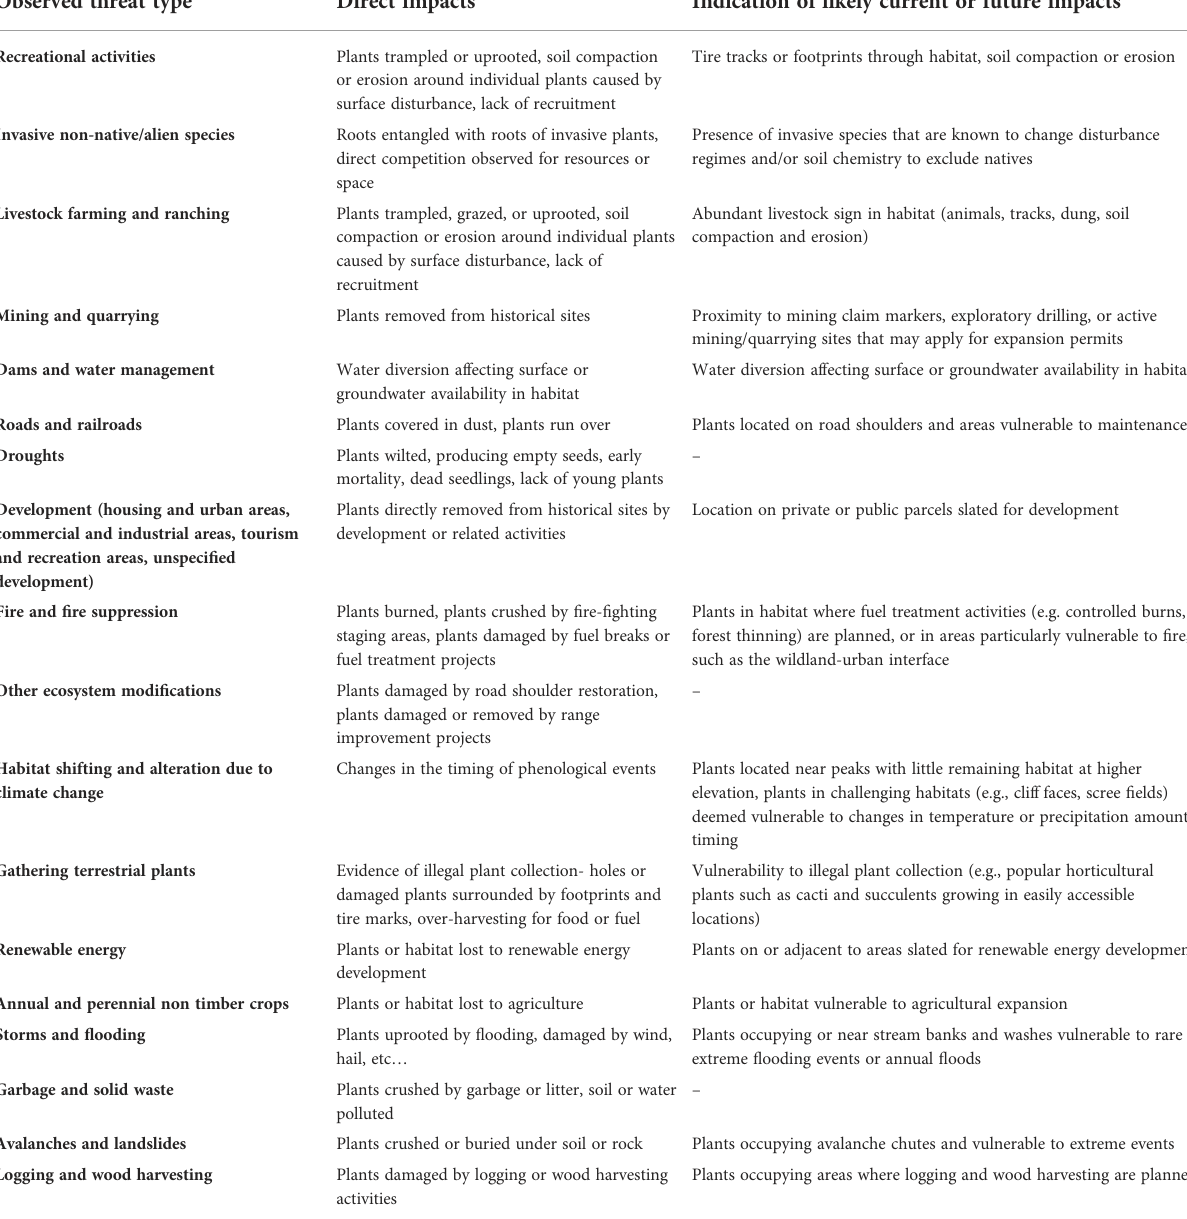
TABLE 1 Examples from 2020-2021 fi eldwork and Nevada Division of Natural Heritage data of impacts that warranted notation as observed threats for each threat